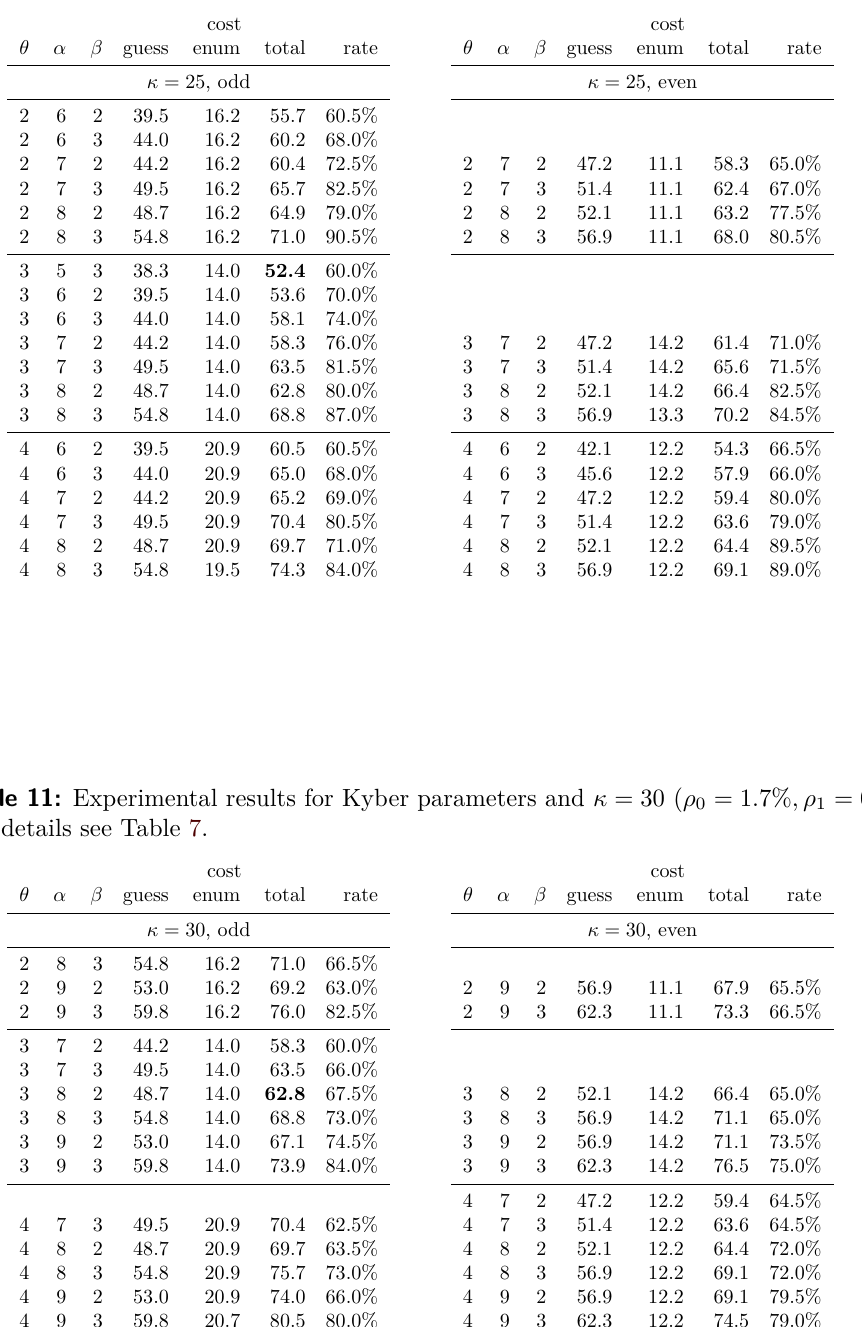
Table 10: Experimental results for Kyber parameters and κ = 25 ( ρ 0 = 1 . 4% , ρ 1 = 0 . 1%). For details see Table 7.